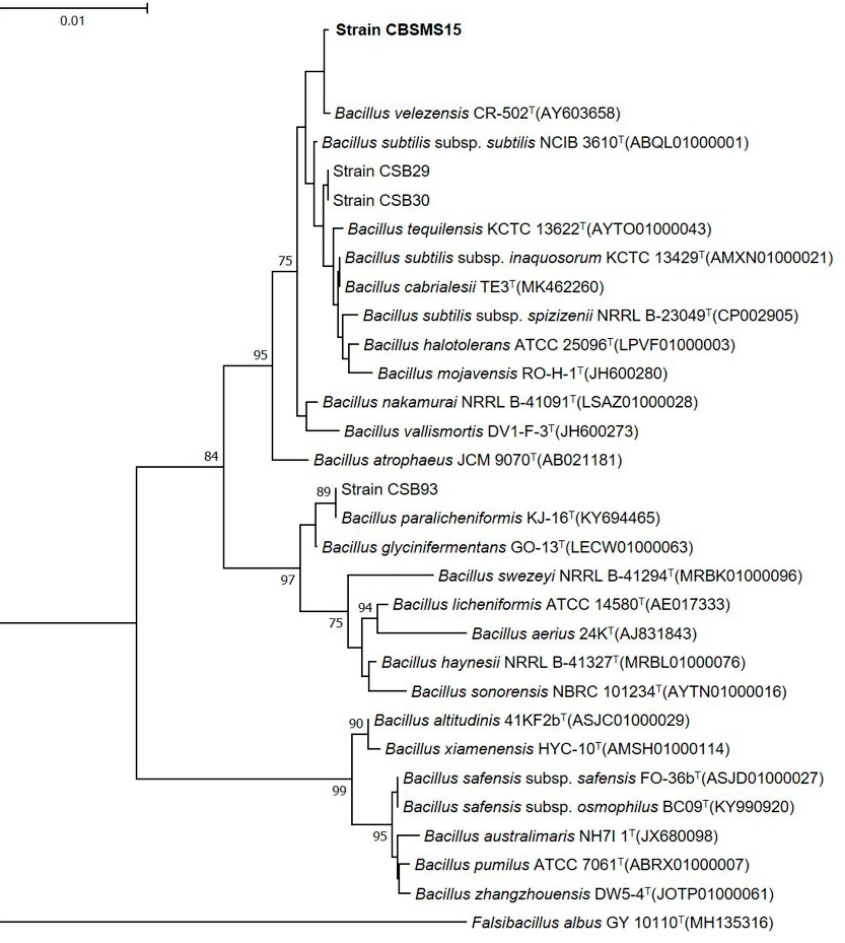
Figure 1. Phylogenetic tree, established on a full sequence of 16S rRNA genes, indicating the correlation among the CBSMS15 strain and closely linked Bacillus -type taxa. Node numbers are percentage bootstrap values based on 1000 replicates above values. The bar reflects 0.01 replacements by nucleotide type.